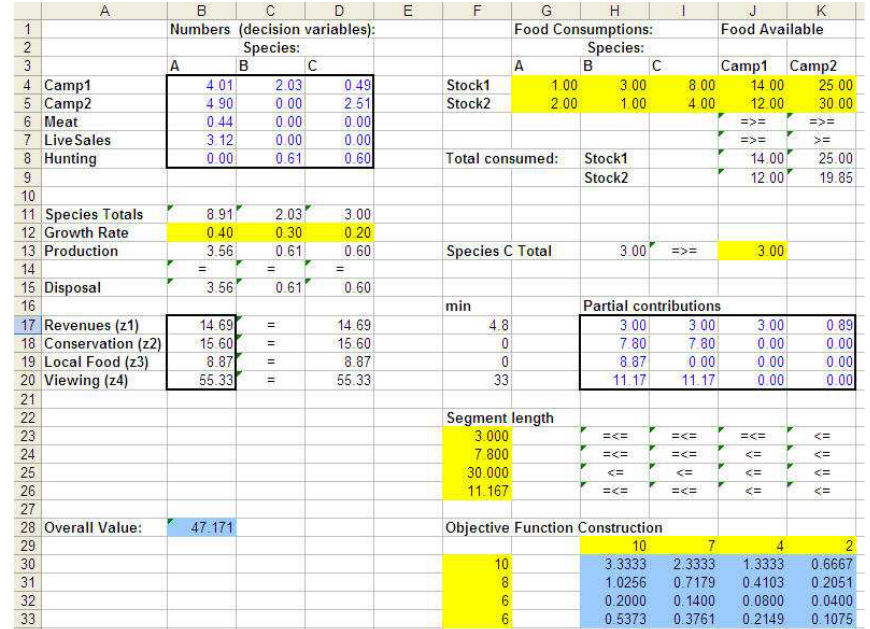
Figure 3: Piecewise linear value theory formulation for the game reserve planning